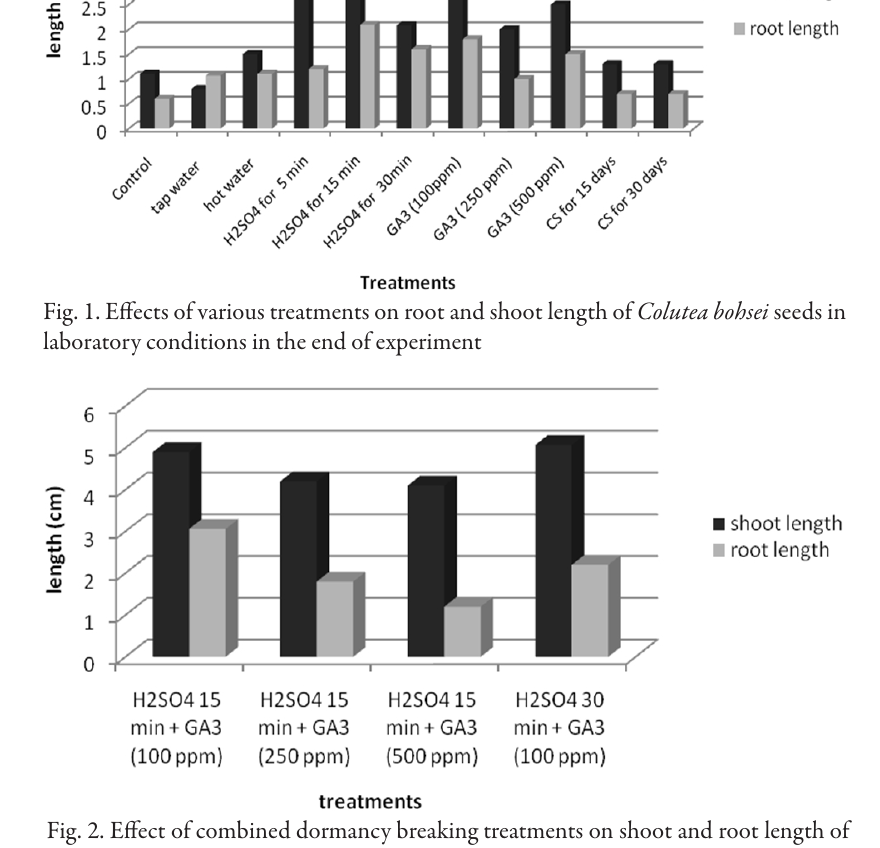
Germination Germination rate percentage (%) (in day) 22.5 f 4.1 fg 2.3 gh 6 ef 10.2 d